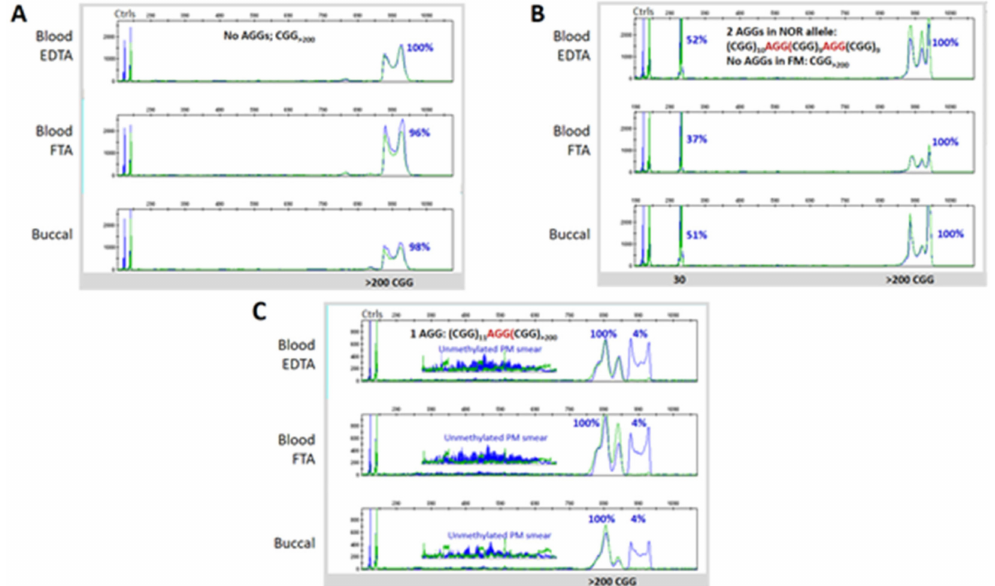
Figure 3. Blood samples collected in EDTA tubes or spotted on FTA paper used only for DNA analyses were compared with cheek swab specimens. DNA analyses from three representative FM subjects are shown. ( A ) Male with FXS (sample 09) with a fully methylated expansion and no detectable size or methylation mosaicism. ( B ) Female with FXS (sample 19) with random X-inactivation of the normal allele and a fully methylated FM allele. ( C ) Male with FXS (sample 02) with FM, PM size and methylation mosaicism in both blood and buccal gDNA. Capillary electrophoresis traces show CGG repeat length (blue, undigested) and methylation status (green,